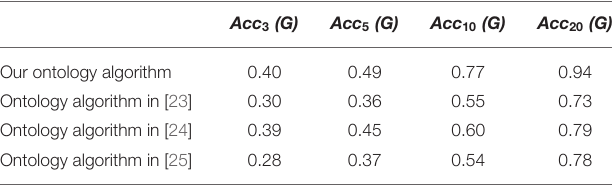
TABLE 1 | The experiment results on new ontology for N = 3, 5, 10, and